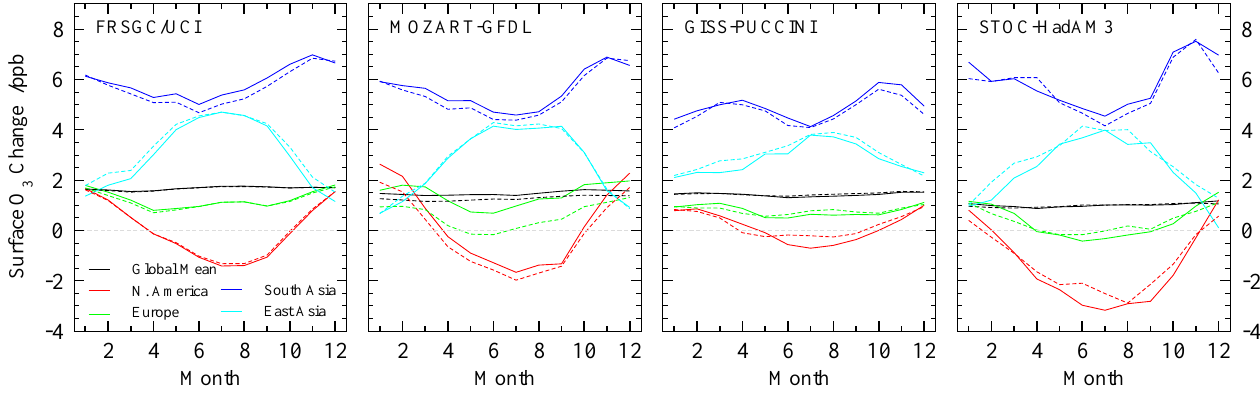
Fig. 5. Monthly regional mean surface O 3 changes between 2000 and 2030 following the RCP 8.5 scenario with the FRSGC/UCI CTM, MOZART-GFDL CTM, GISS-PUCCINI GCM, and STOC-HadAM3 GCM (solid lines) and the parameterized estimate for each model (dashed lines). Table 2. Chemistry transport models used to generate parameterization. CAM-CHEM GEM-AQ INCA-LMDz MOZECH TM5-JRC EMEP GISS-PUCCINI LLNL-IMPACT STOC-HadAM3 UM-CAM FRSGC/UCI GMI MOZART-GFDL